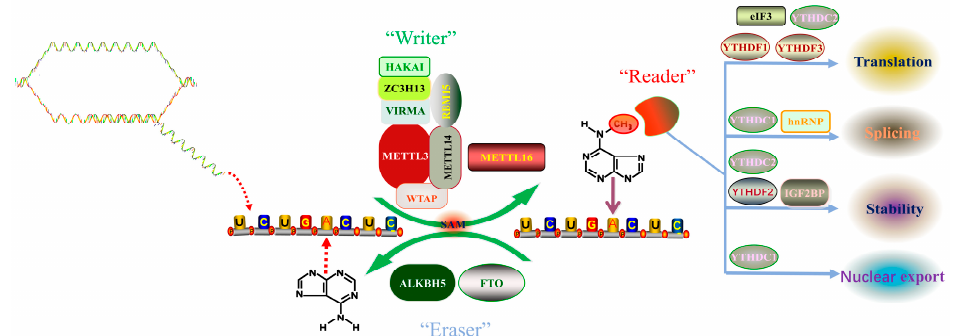
Figure 1. Dynamic m6A modification of RNA. Abbreviations: METTL3 (Methyltransferase-like protein 3); METTL14 (Methyltransferase-like protein 14); WTAP (Wt1 Associated Protein); KIAA1429 (Vir Like M6A Methyltransferase Associated, VIRMA); RBM15 (RNA Binding Motif Protein 15); HAKAI (Cbl Proto-Oncogene Like 1); ZC3H13 (Zinc Finger Ccch-Type Containing 13); METTL16 (Methyltransferase-like protein 16); FTO (Fat Mass and Obesity Associated Protein); ALKBH5 (Alkb Homolog 5, RNA Demethylase); eIF3 (eukaryotic initiation factor 3); hnRNP (heterogeneous nuclear ribonucleoprotein); YTHDF2 (Yth N6-Methyladenosine RNA Binding Protein 2); YTHDF1 (Yth N6- Methyladenosine RNA Binding Protein 1); YTHDF3 (Yth N6-Methyladenosine RNA Binding Protein 3); YTHDC1 (Yth Domain Containing 1); YTHDC2 (Yth Domain Containing